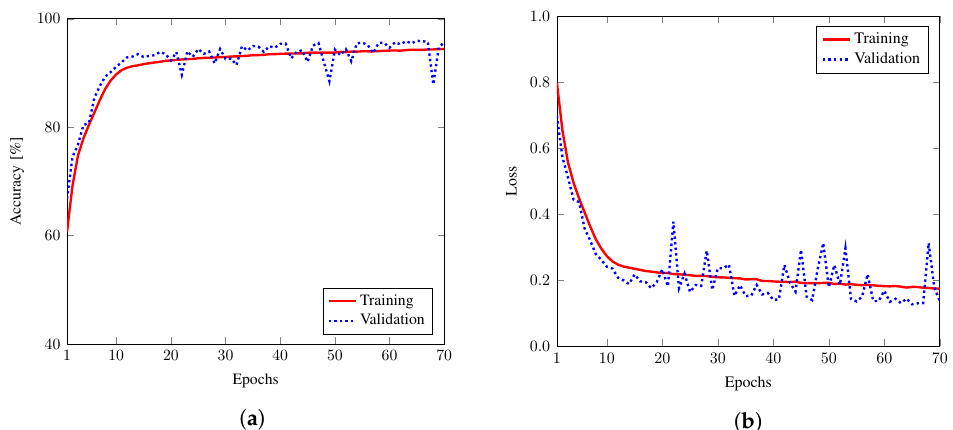
Figure 7. Training/validation ( a ) accuracy and ( b ) loss of the Bell-DNN ( 8,3,80 ) classifier as a function of the number of epochs for Svetlichny features.